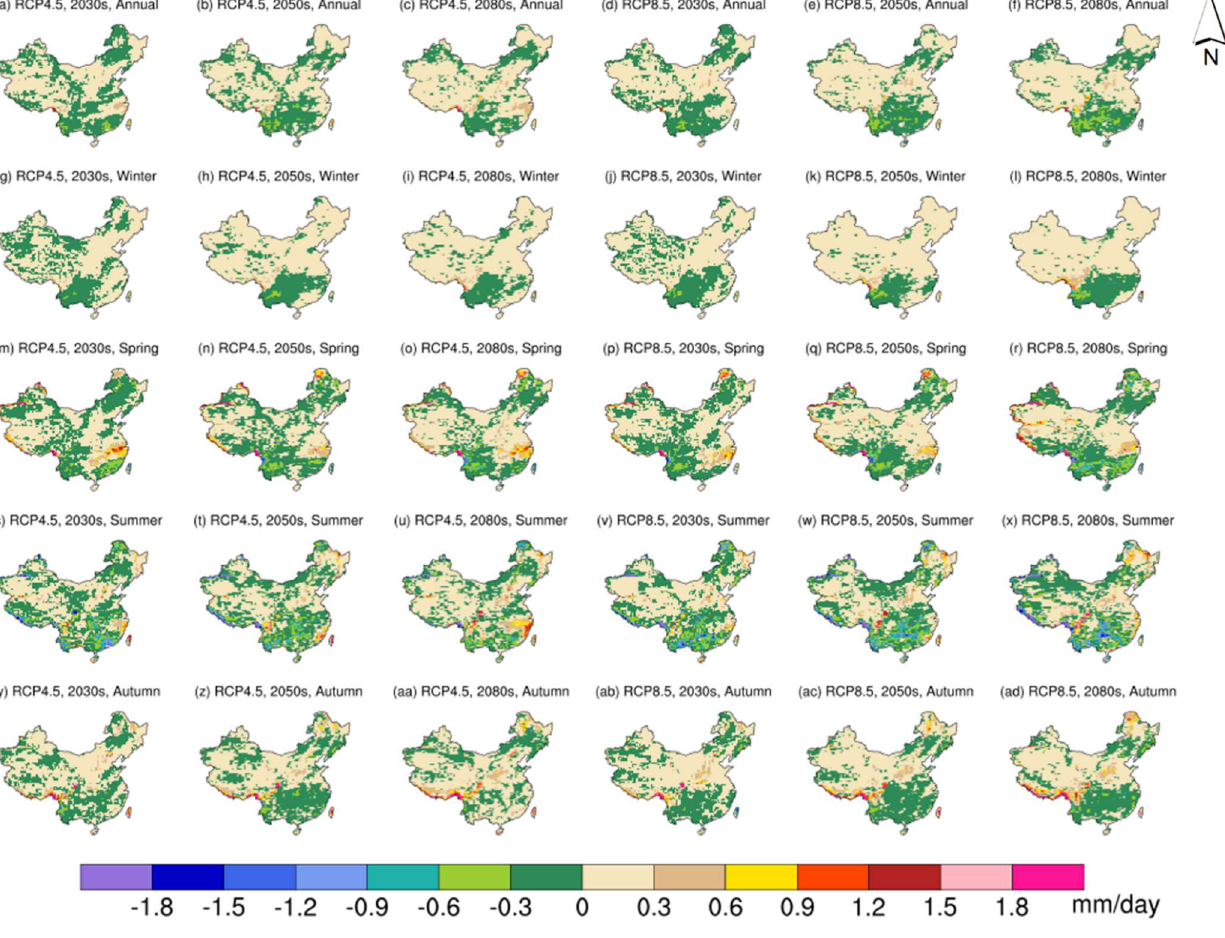
Figure 10. Projected changes in runoff over China.